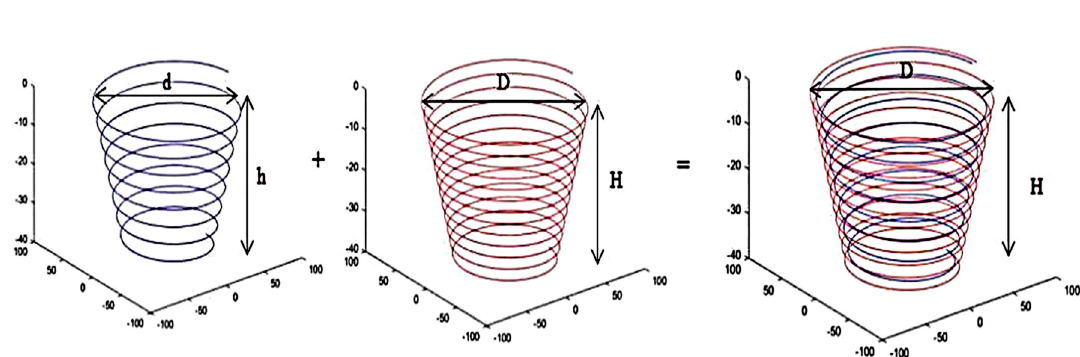
Figure 4. The two forming stages of the proposed SPIF process.